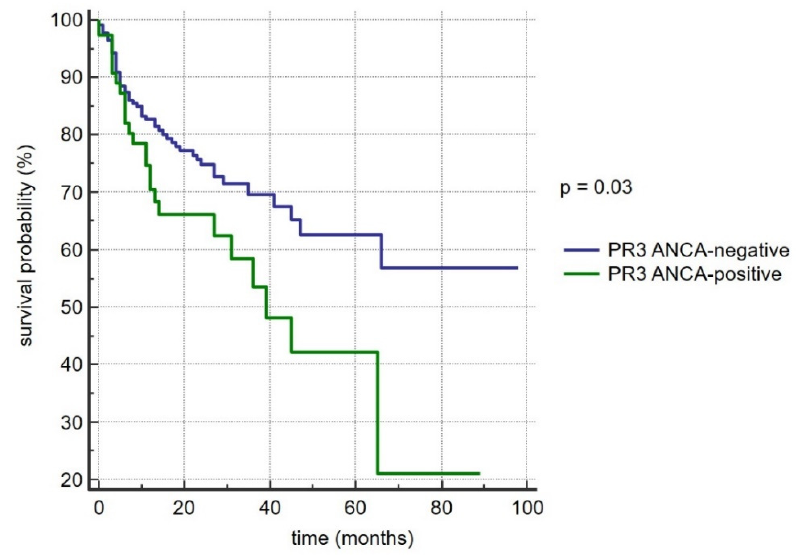
Figure 2. Kaplan–Meier survival curve for 309 patients with primary sclerosing cholangitis, depending on PR3-ANCA status. Table 5. Cox proportional-hazards regression of independent variables for the risk prediction of poor survival (liver transplantation or death) in 309 patients with primary sclerosing